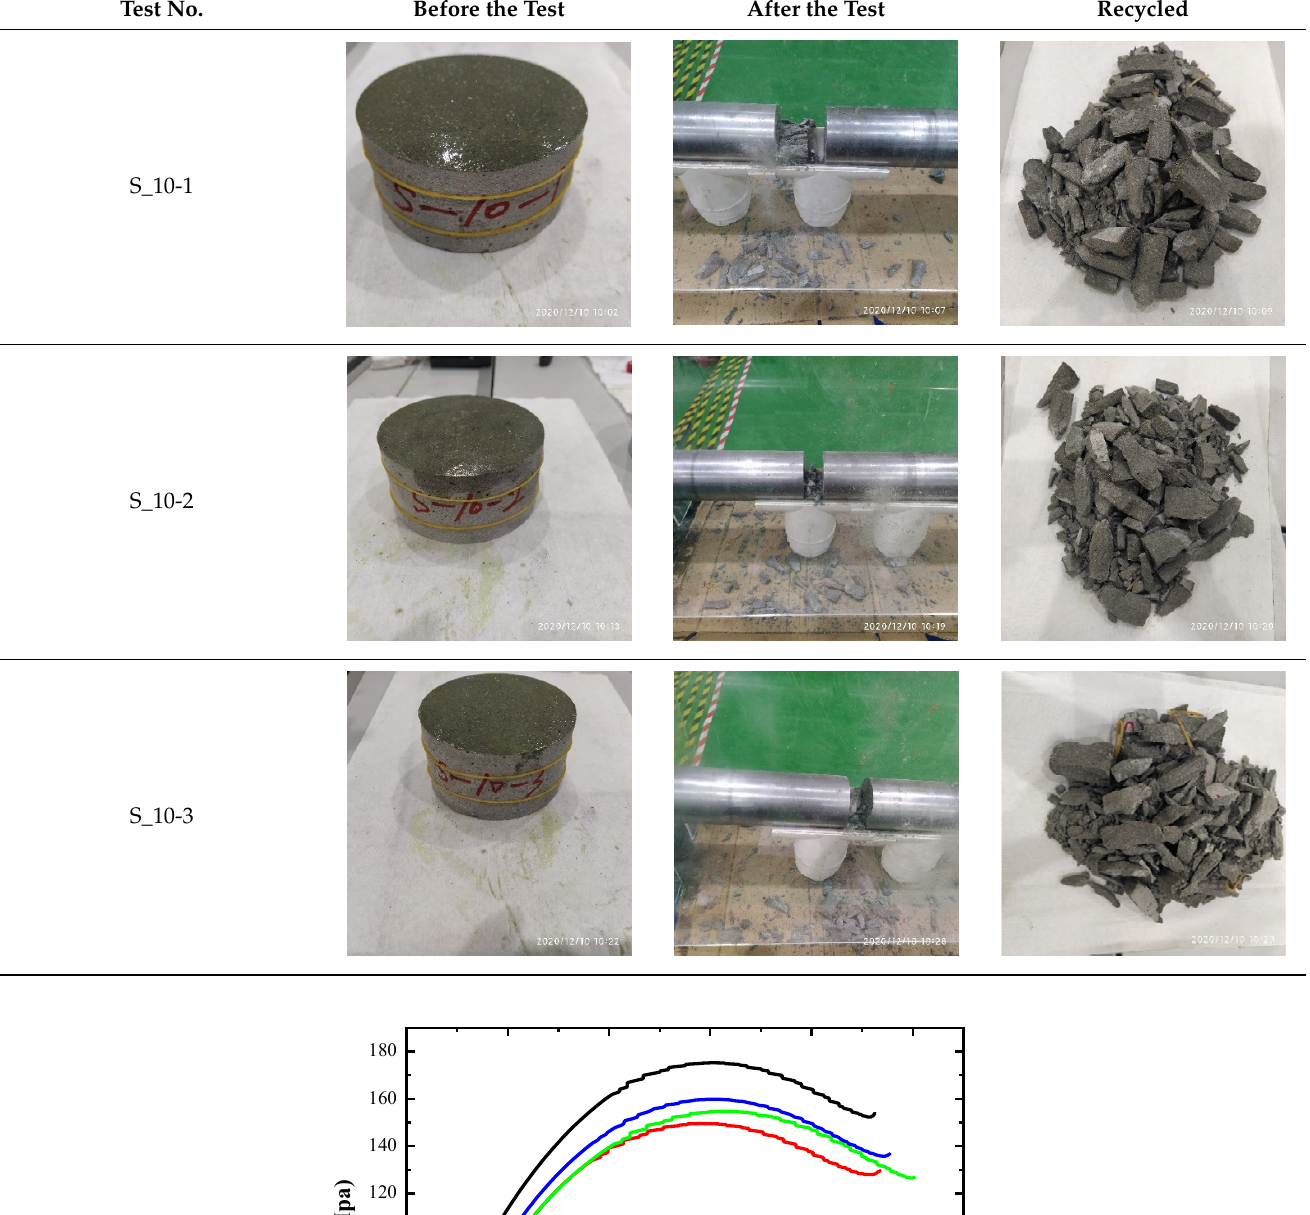
Table 4. Test results at an impact velocity of 10 m/s.